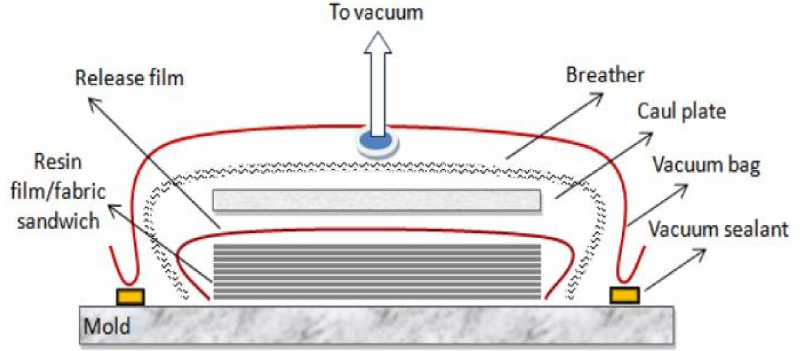
Figure 14. Schematic of Resin Film Infusion (RFI). Reprinted with permission from [123]. Copyright (2022) American Chemical